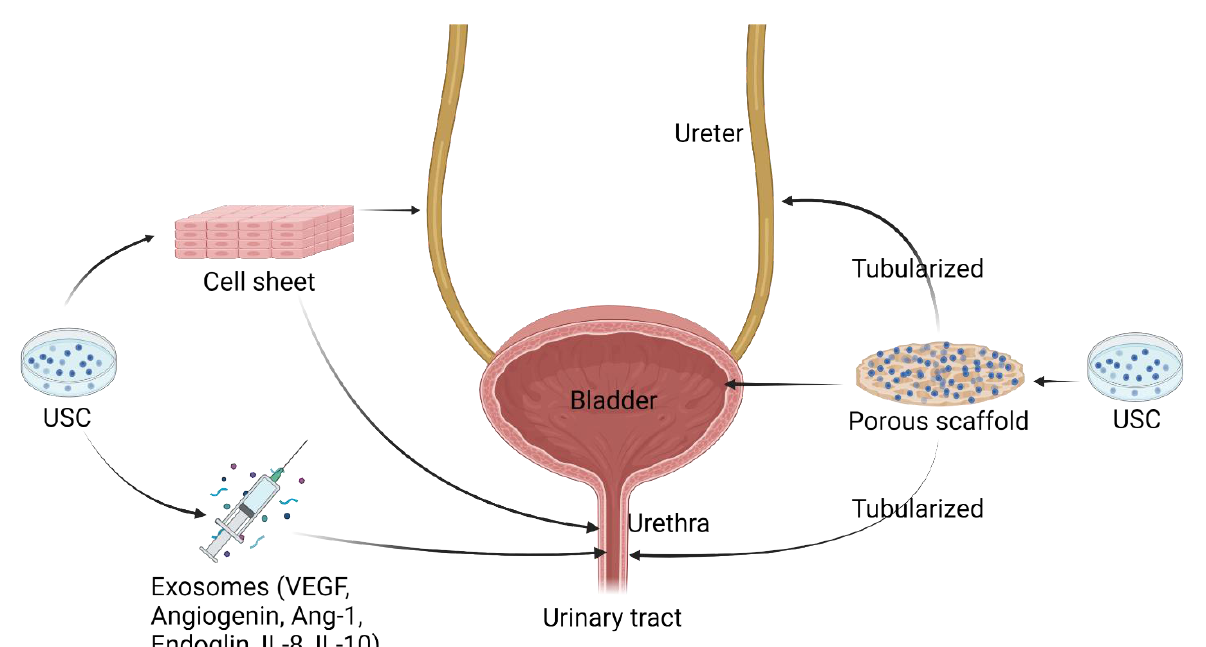
Figure 7. Applications of USC in urothelial mucosa reconstruction. The combination of USC and flat or suberized biomaterial scaffolds as implantation has been investigated in bladder repair, ureter, and urethra reconstruction. The injection of growth and immunoregulatory factors secreted from USC shows effectiveness in the treatment of urethral stricture. USC, urine-derived stem cell; VEGF, vascular endothelial growth factor; Ang, angiogenin; IL, interleukin. Created with BioRender.com accessed on 27 July 2022.